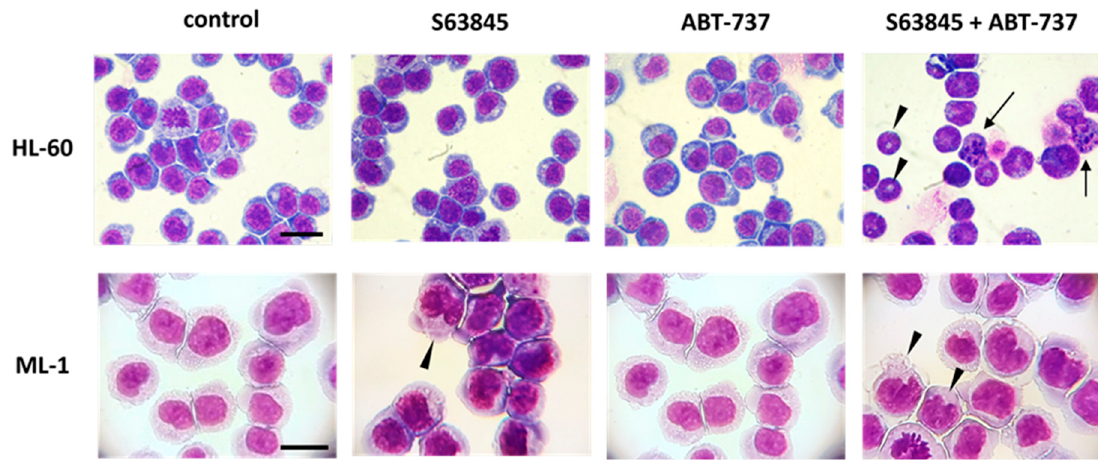
Figure 3. Morphological changes of AML cells following 48 h treatment with S63845 and ABT-737. Representative images of HL-60 and ML-1 cells stained with Hemacolor demonstrating cells with characteristic features of apoptosis (arrows) and di ff erentiation (arrowheads). Scale bar = 20 µM.